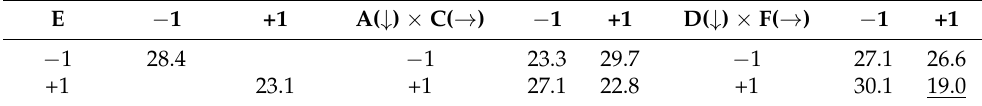
Table 14. Analysis of the effect of factor E and the interactions AC + DF. Wear in zone III at 250 ◦ C (mg).